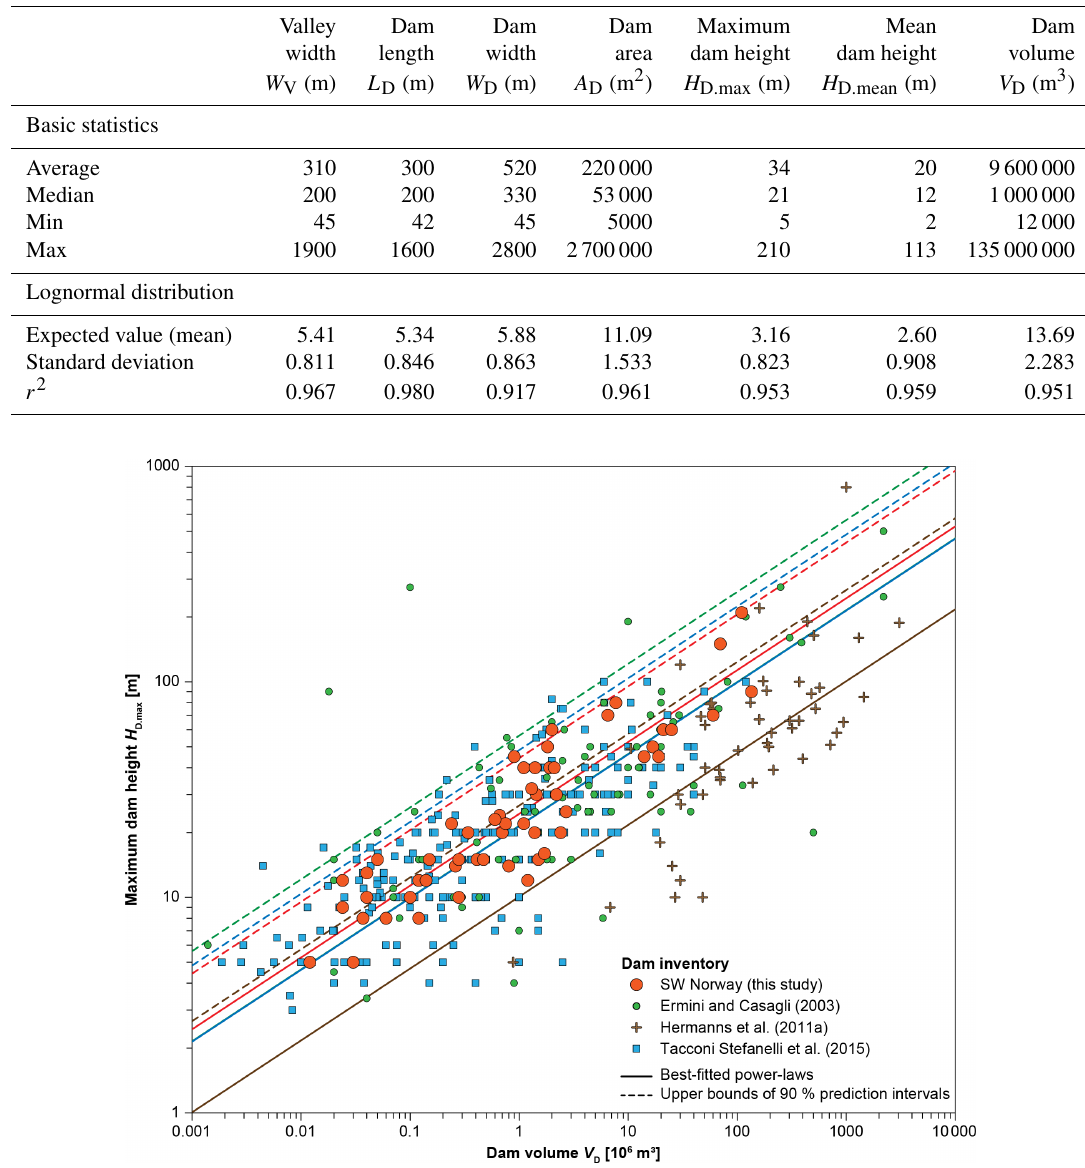
Table 1. Descriptive statistics of RSF dam dimensions in southwestern Norway and lognormal distributions matching the cumulative fre- quency distributions of the dimensions.